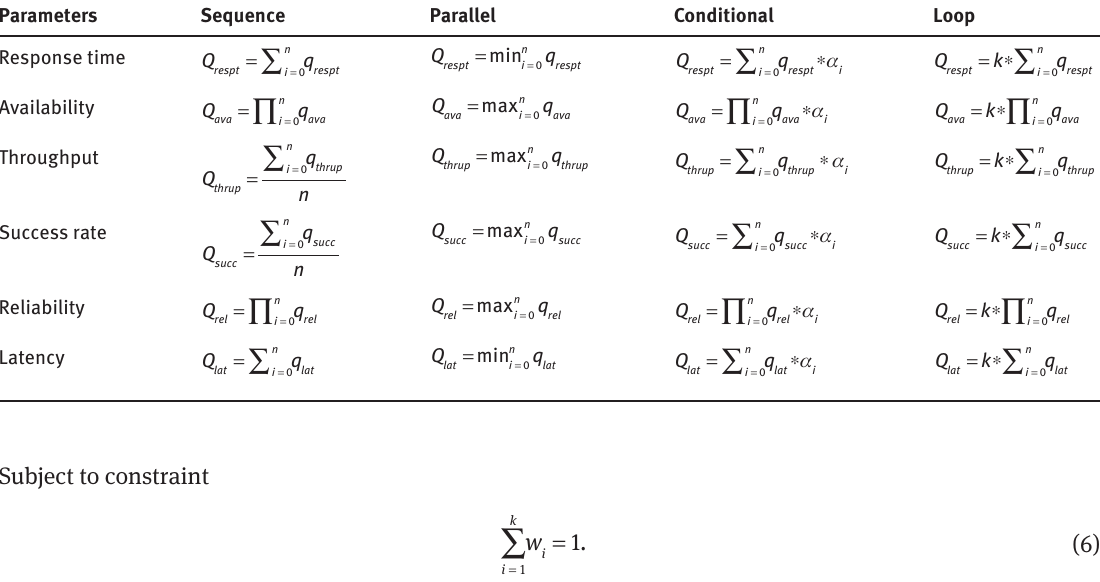
Table 1: Aggregate QoS for Various Structures.